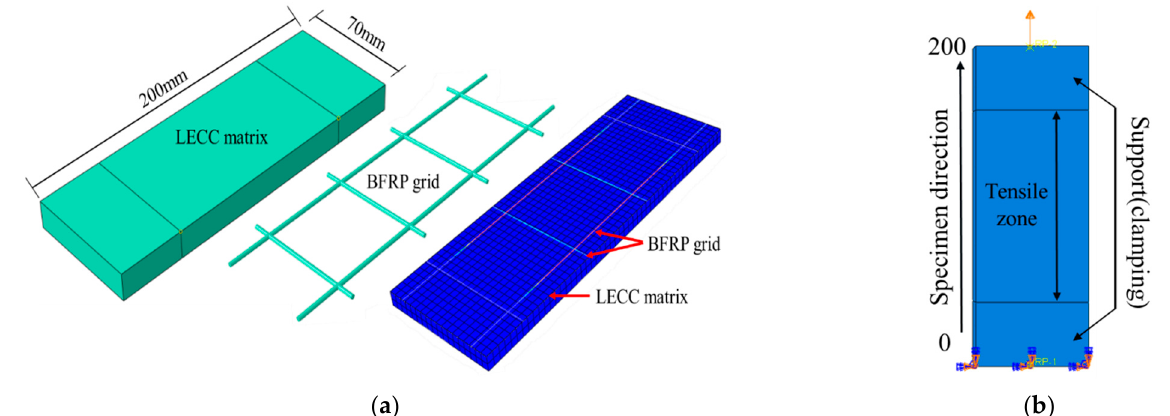
Figure 13. Finite element model. ( a ) Details of the LECC matrix and BFRP grid, ( b ) Schematic diagram of tensile test.